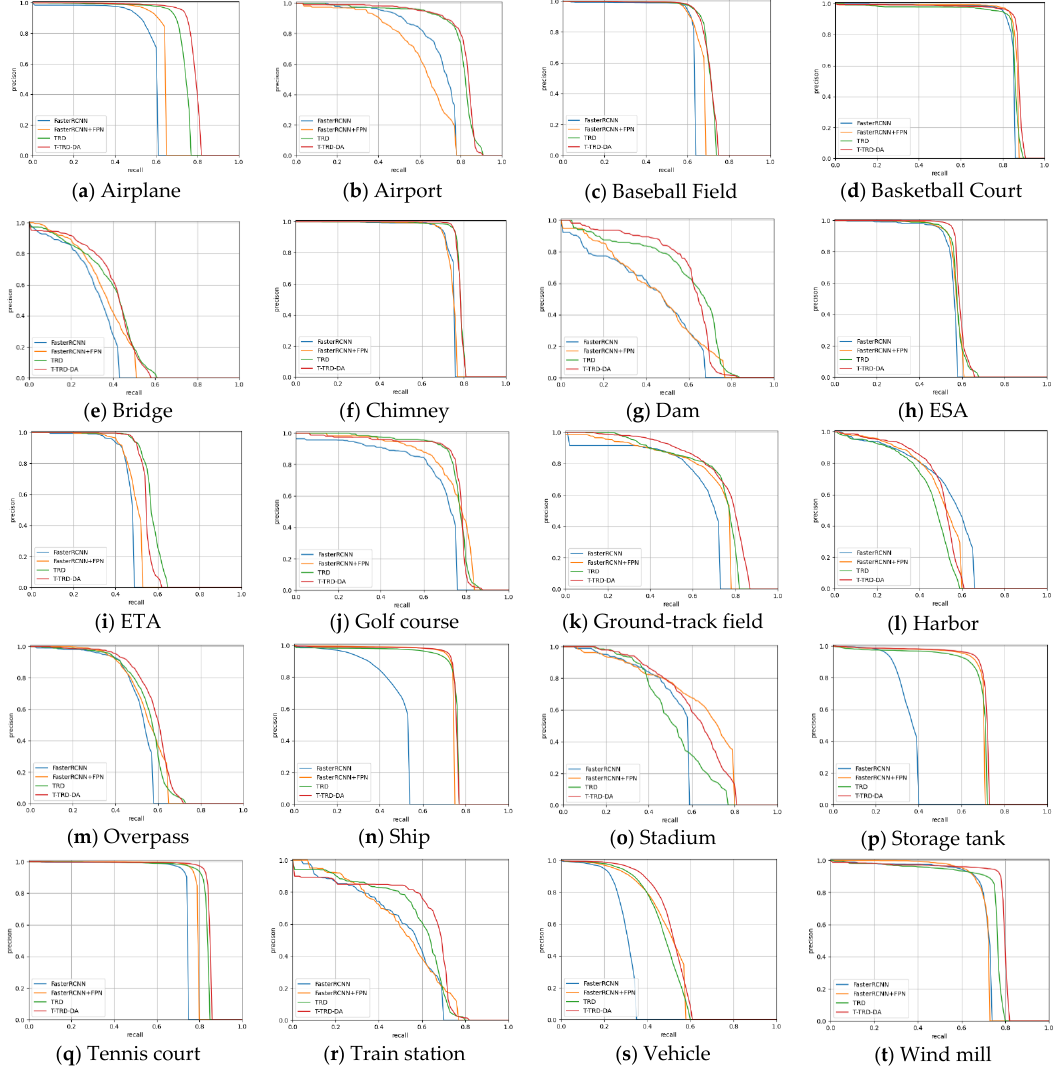
Figure 9. The p – r curve of the detectors on each category of the DIOR data set. Figure 9. The p–r curve of the detectors on each category of the DIOR data